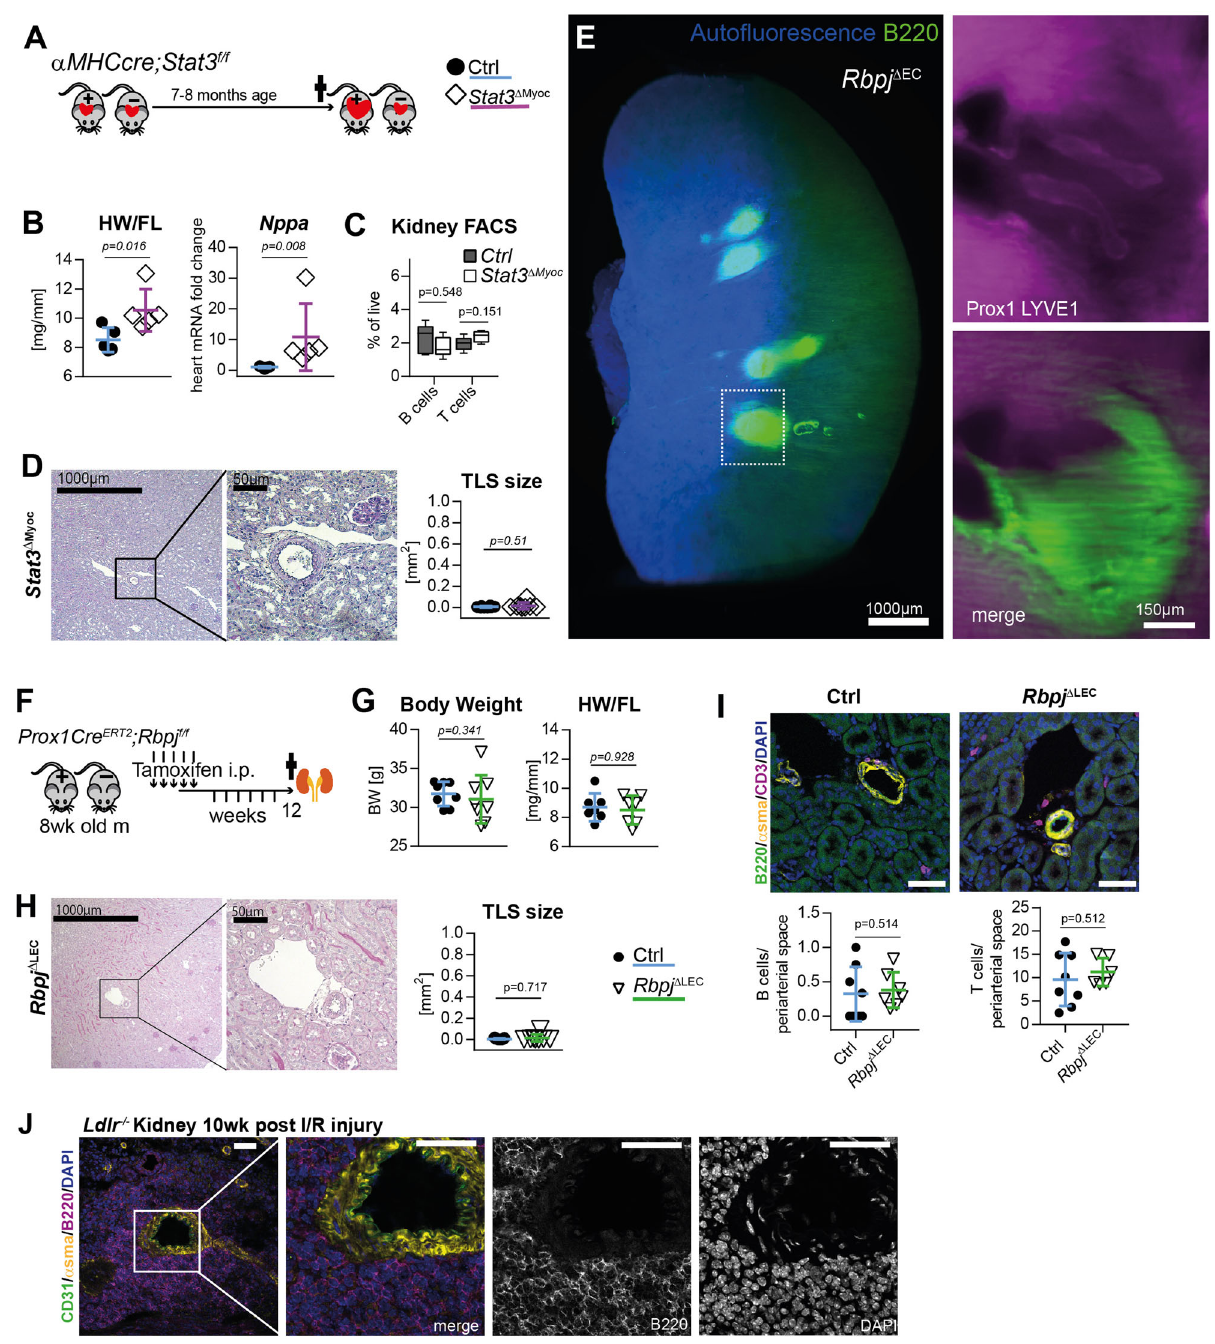
per sample. Principal component analysis revealed predominant clustering by genotypes, corroborating genetic interference in mutant kidney ECs (Fig. 5A). Hey1 and Jag1 were downregulated in Rbpj Δ EC endothelial cells, corresponding to whole kidney QRT results (DeSeq2 results are provided in Supplementary Data fi le 1, a heatmap of differentially regulated genes in Suppl. data fi le 4; a Volcano plot with differentially regulated genes in Supplementary Fig. 5D). Using gene set enrichment analysis (GSEA), we found that loss of Rbpj in kidney ECs resulted in 1837 gene sets being signi fi cantly downregulated, while 123 gene sets were signi fi cantly upregulated. A selection of up- and downregulated Gene Ontology (GO) terms with their respective normalized enrich- ment score (NES) is shown in Fig. 5B (full results